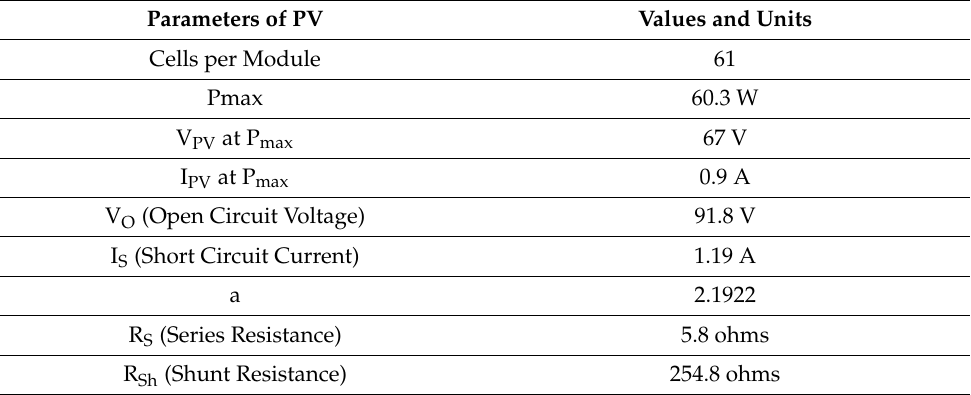
Table 1. The characteristic parameters of the photovoltaic (PV) panel Kaneka G-SA060 [32,33,38].